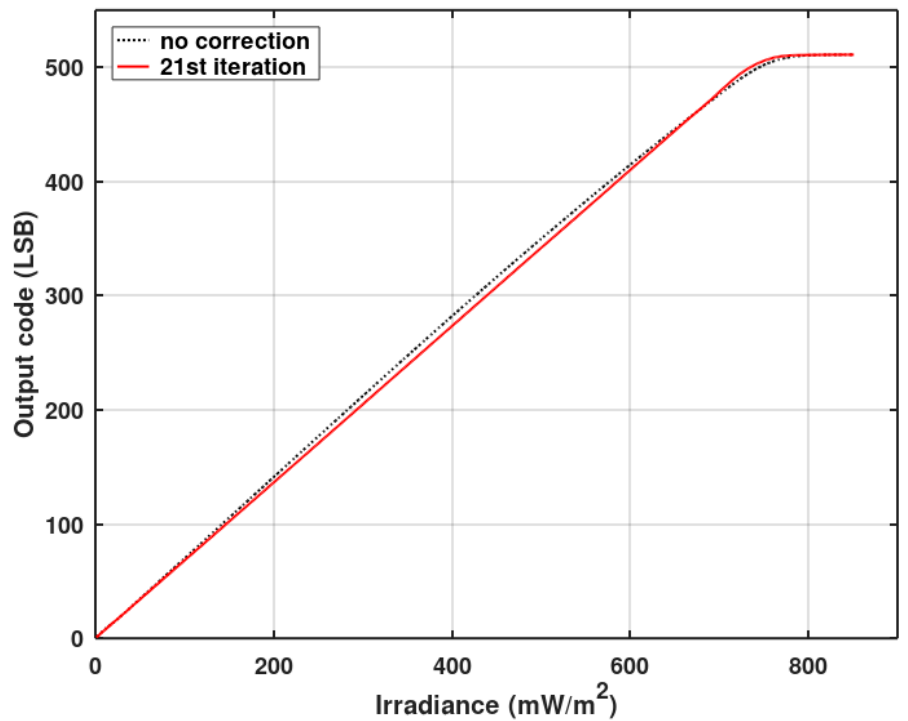
Figure 16. The measured response of the imager (with the gain and offset correction disabled). The presented response is an average of 128 pixels.